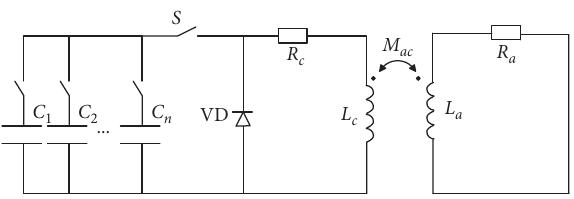
Figure 12: Circuit model equivalent to the mechanism.